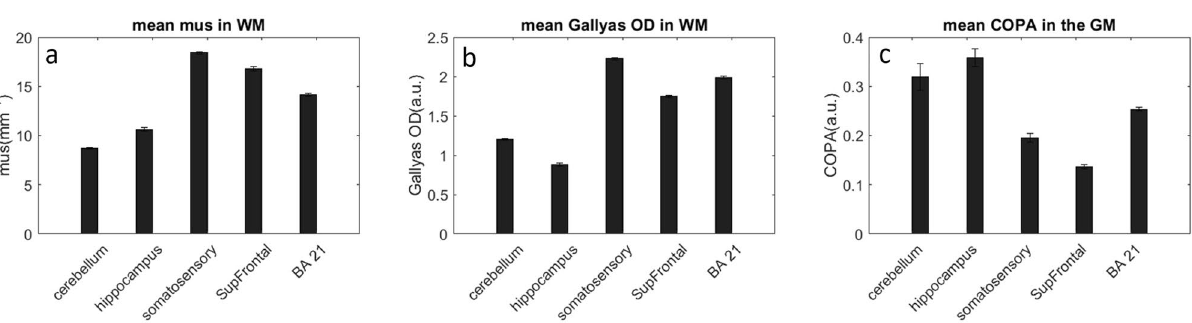
Figure 5. (a) Average µ s , (b) average Gallyas OD in white matter and (c) average COPA in grey matter differentiating brain regions. The error bars represent the standard error from the